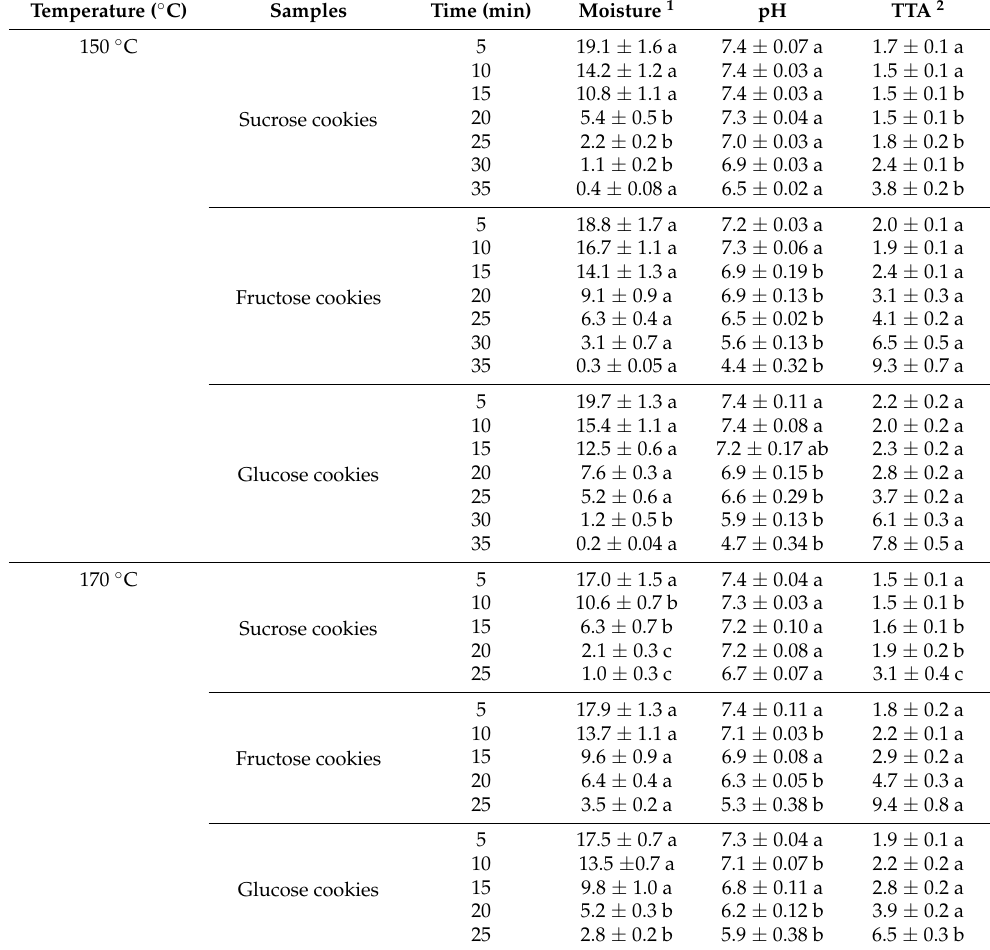
Table 1. Evaluation of the chemical characteristics of the cookie samples during temperature and time of